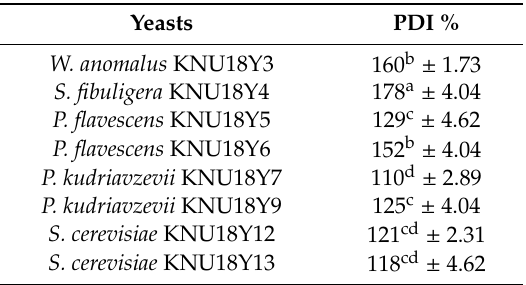
Table 3. Pectin degradation index after 5 days incubation on YPDA media that supplemented a citrus